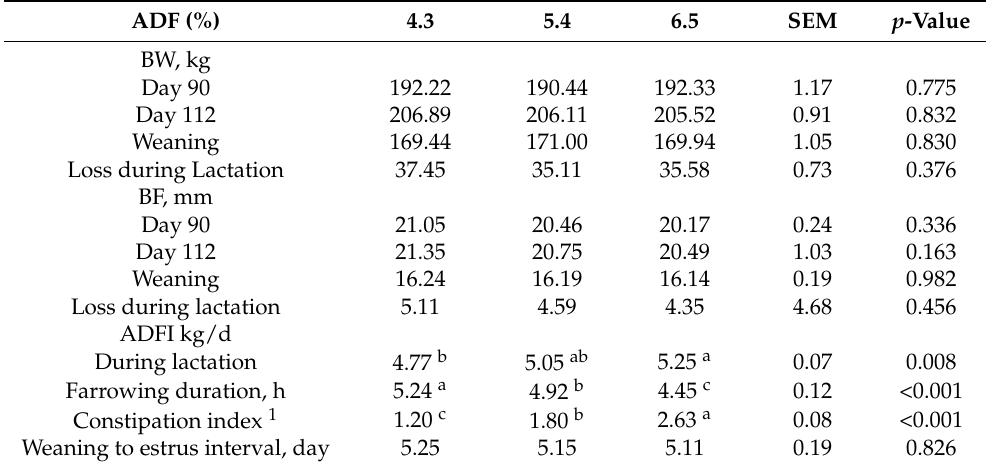
Table 1. Effect of dietary acid detergent fiber (ADF) levels in gestation diets on sows’ performance. ADF